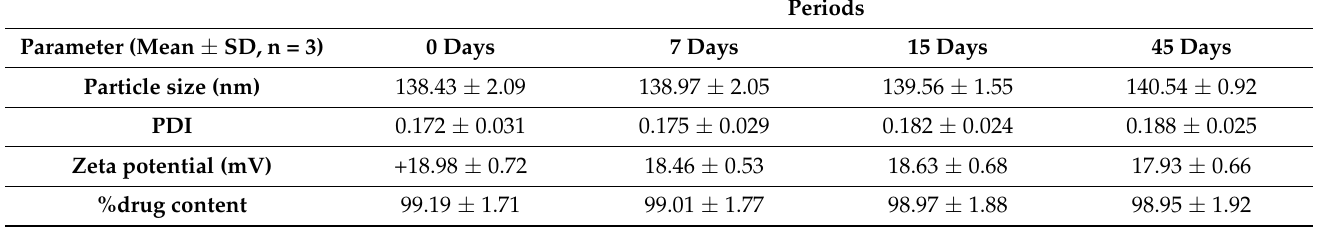
Table 7. Physical stability of the optimized formulation of CUR/LCSNPs within 45 days. Periods